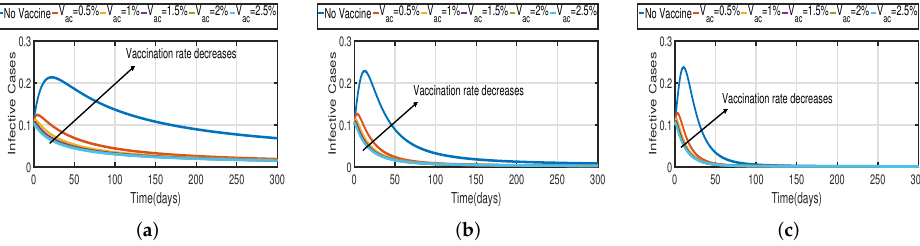
Figure 5. The trend of infected individuals with respect to different vaccination rates V ac . ( a ) Fractional-order α = 0.62. ( b ) Fractional-order α = 0.83. ( c ) Fractional-order α = 0.94.